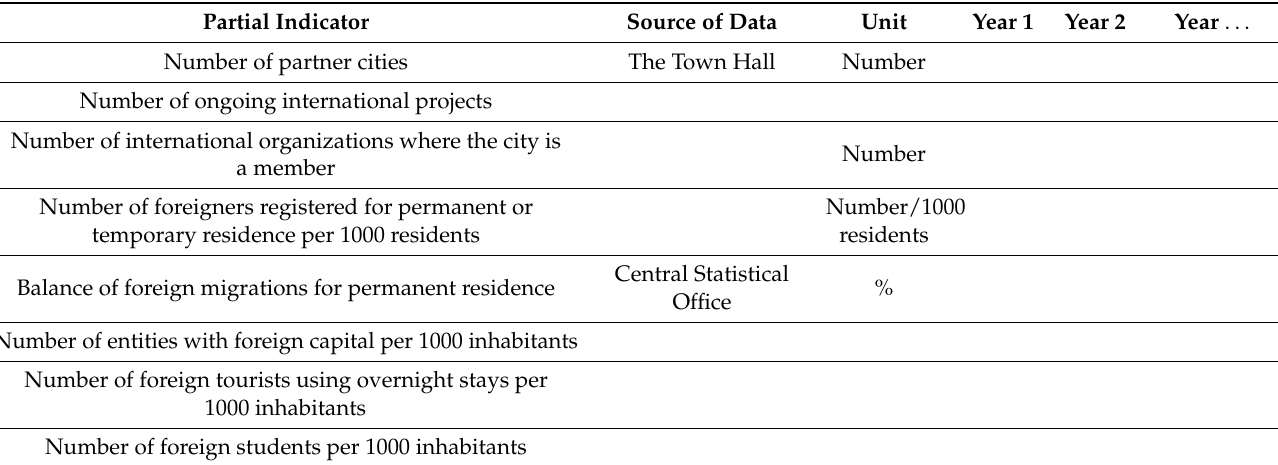
Table 3. Area 2 on innovation, entrepreneurship, city image, efficiency, labor market and international integration.